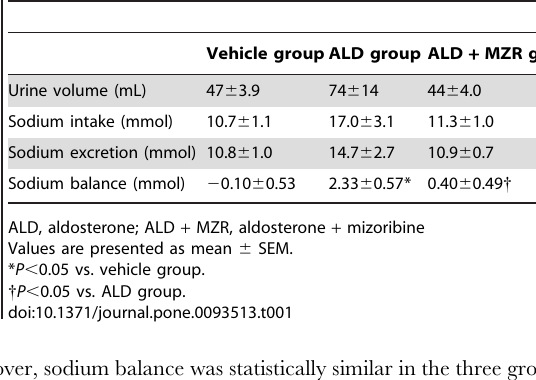
Table 1. Biological markers at 14 days after the addition of 1% sodium chloride to the drinking water.